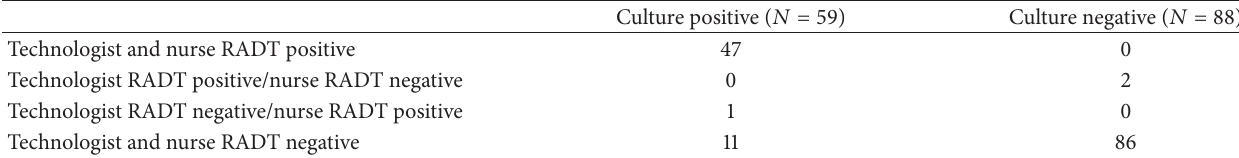
Table 2: Comparison of technologist-performed RADT and nurse-performed